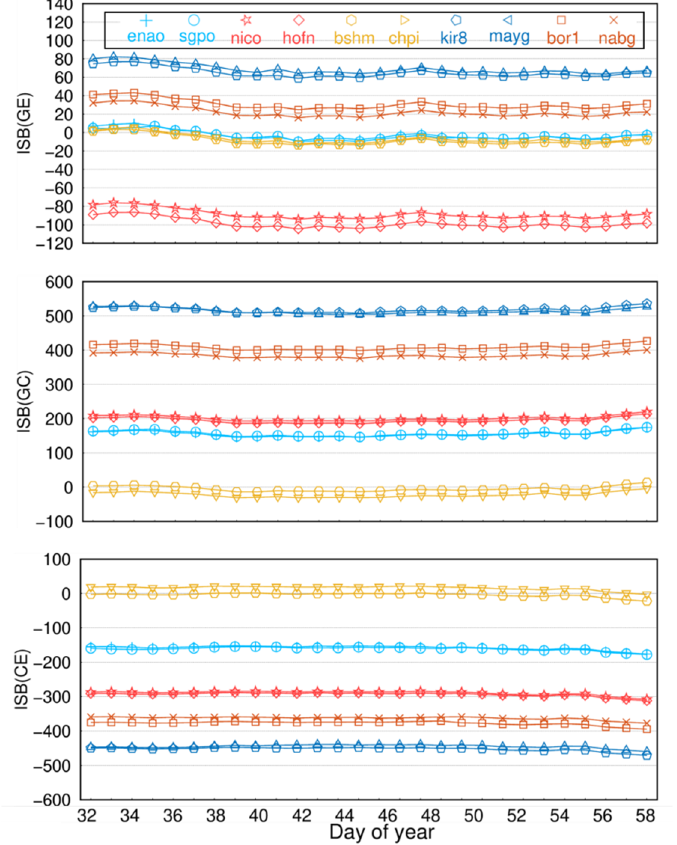
Figure 19. Average value of daily single-frequency ISB for 10 tracking stations of 5 receivers.